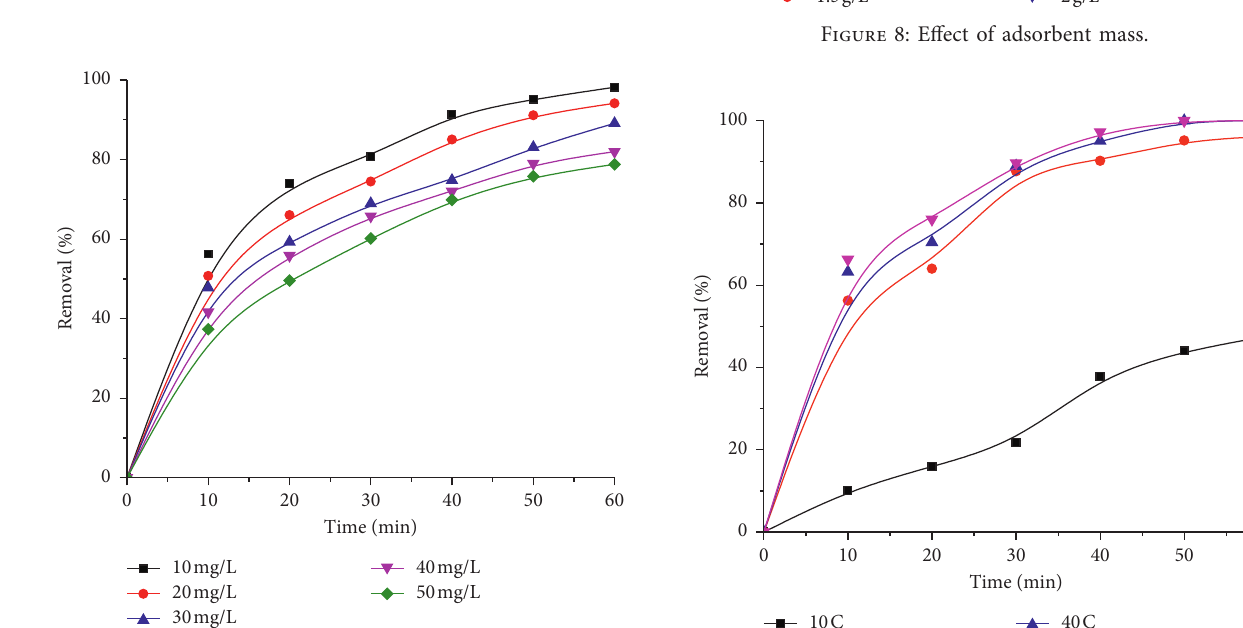
Figure 6: Effect of pH on MB removal.